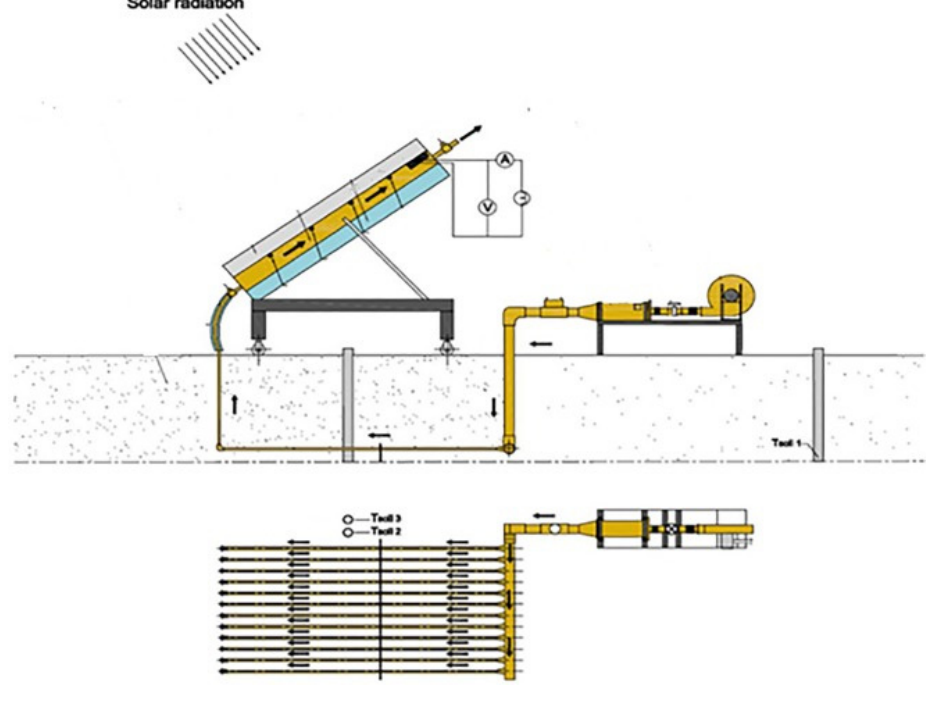
Figure 45. Schematic diagram of an air-cooling system in a PV system [176].